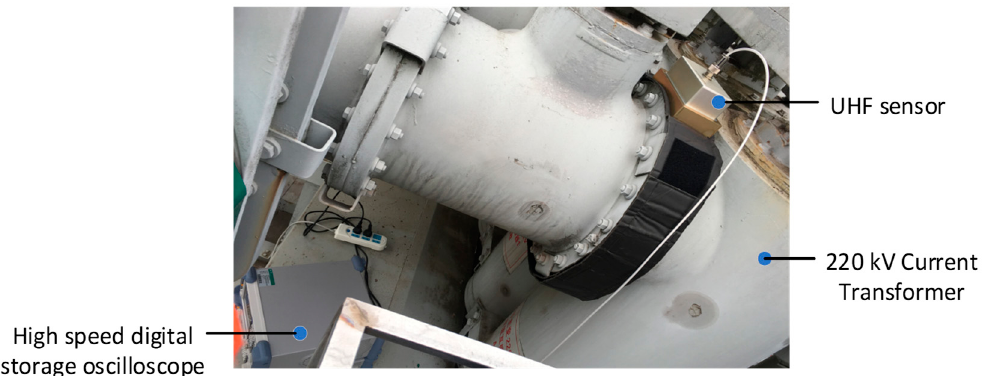
Figure 16. Field picture of the PD detection.